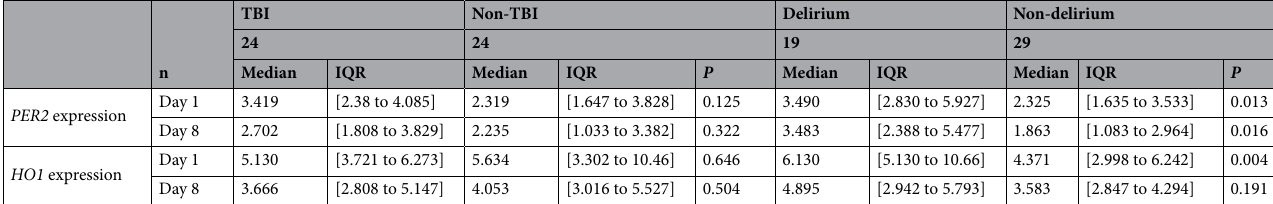
Fig. 4f) expression. Relative risk to develop delirium was 2.92 (95% CI 1.15–4.64) for patients with high PER2 and 2.40 (95% CI 1.18–5.07) for patients high HO1 expression. Correspondingly, the odds ratios of developing delirium with high expression levels were 4.32 ( PER2 , 95% CI 1.14–13.87) and 4.5 ( HO1 , 95% CI 1.23–14.42), respectively. Patients classified as delirious according to their maximum nuDesc showed significantly higher SDs of nuDesc during their hospital stay ( P < 0.0001, Fig. 4g). Bilirubin concentration neither correlated with maximum nuDesc (r = 0.065, P = 0.663, r 2 = 0.011, P = 0.486, data not shown) nor were patients with high bilirubin levels more likely to develop delirium compared to those with low levels ( P = 0.770, data not shown). TBI influences PER2 expression but not HO1 expression or occurrence of delirium. As shown in Table 2, no significant differences in mRNA expressions were apparent for either PER2 or HO1 between groups of TBI and non-TBI patients. However, there was a tendency towards elevated values of PER2 on day one after trauma in TBI patients with a relative risk of 2.00 (95% CI 0.94–4.52) and an OR of 3.00 (95% CI 0.84–9.33, P = 0.125). A similar non-significant tendency was apparent when comparing the distribution of high and low PER2 mRNA expression on day one after trauma comparing TBI and non-TBI ( P = 0.135, Fig. 5a). Distribution of high and low HO1 mRNA expression and bilirubin concentration showed no difference between TBI and non-TBI patients ( HO1 : P = 0.770; bilirubin: P = 0.561). Similarly, analysis of delirium occurrence in TBI and non-TBI patients revealed no difference in delirium when comparing TBI with non-TBI groups ( P = 0.556). TBI patients show smaller likelihood of developing AKI.